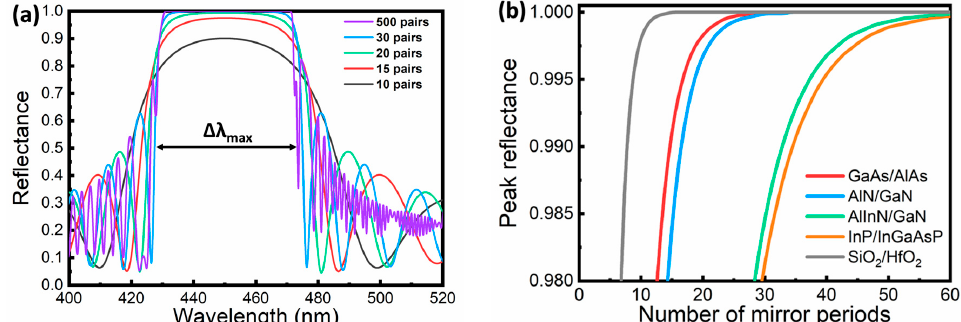
Figure 1. ( a ) Calculated reflectance spectrums of an AlN / GaN distributed Bragg reflectors (DBRs) with a Bragg wavelength λ of 450 nm. The number of DBR pairs is increased from 10 to 500 pairs. See text for the explanation of Δλ max . ( b ) Plots of peak mirror reflectance, R , versus the number of DBR pairs for AlAs/GaAs mirrors (2.95,3.52), InP/InGaAsP lattice matched mirrors (3.17,3.40), AlN/GaN mirrors (2.15,2.52), and AlInN/GaN latticed matched mirrors (2.33,2.52) [44]. Reflectance from a dielectric DBR is also calculated and